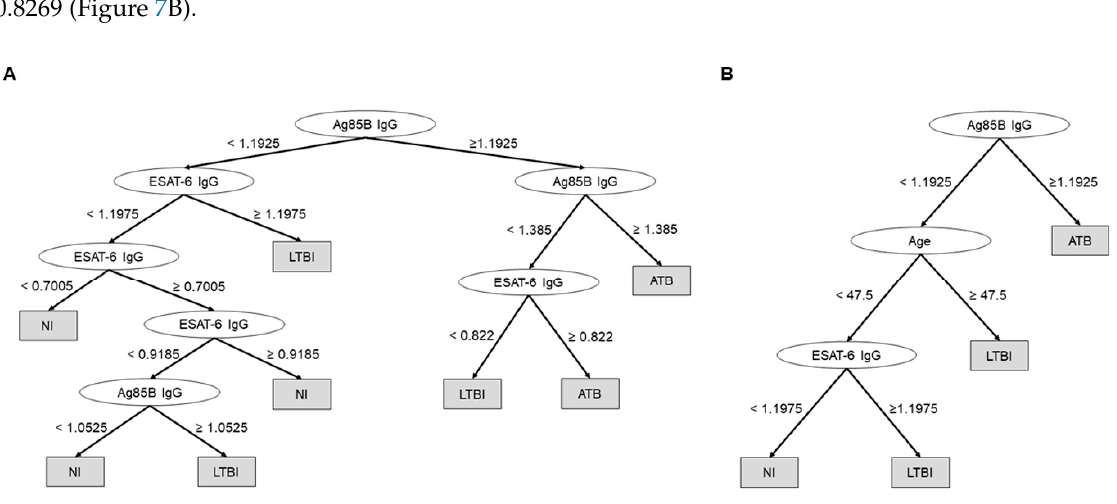
Figure 7. Decision-tree models to comprehensively predict the diagnosis of active tuberculosis (ATB) or latent tuberculosis infection (LTBI), using IgG against Ag85B and ESAT-6 (accuracy = 0.789) ( A ) and using age and IgG against Ag85B and ESAT-6 (accuracy = 0.8269) ( B ).